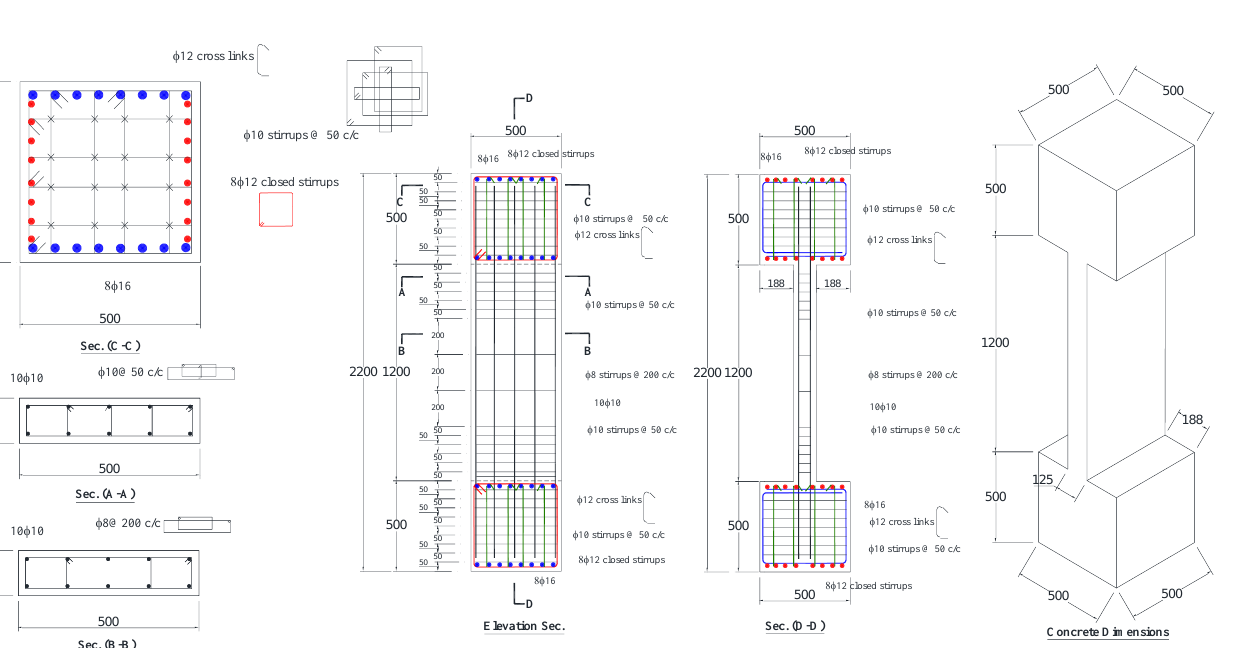
Figure 1. Dimensions and reinforcement detailing of control specimen CW (note: all dimensions are in mm).